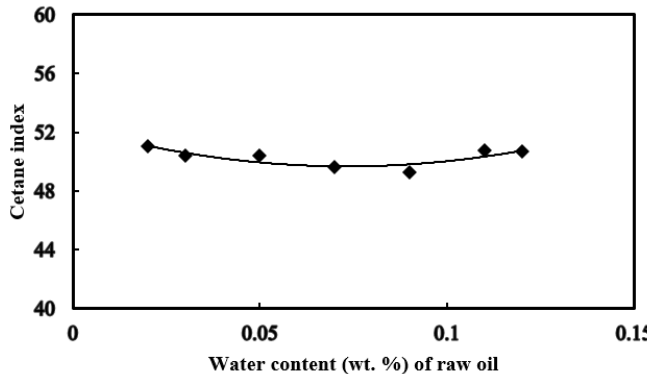
ff ects of added water content in palm oil on the cetane index of the biodiesel Figure 8. Effects of added water content in palm oil on the cetane index of the biodiesel product. Figure 8. E